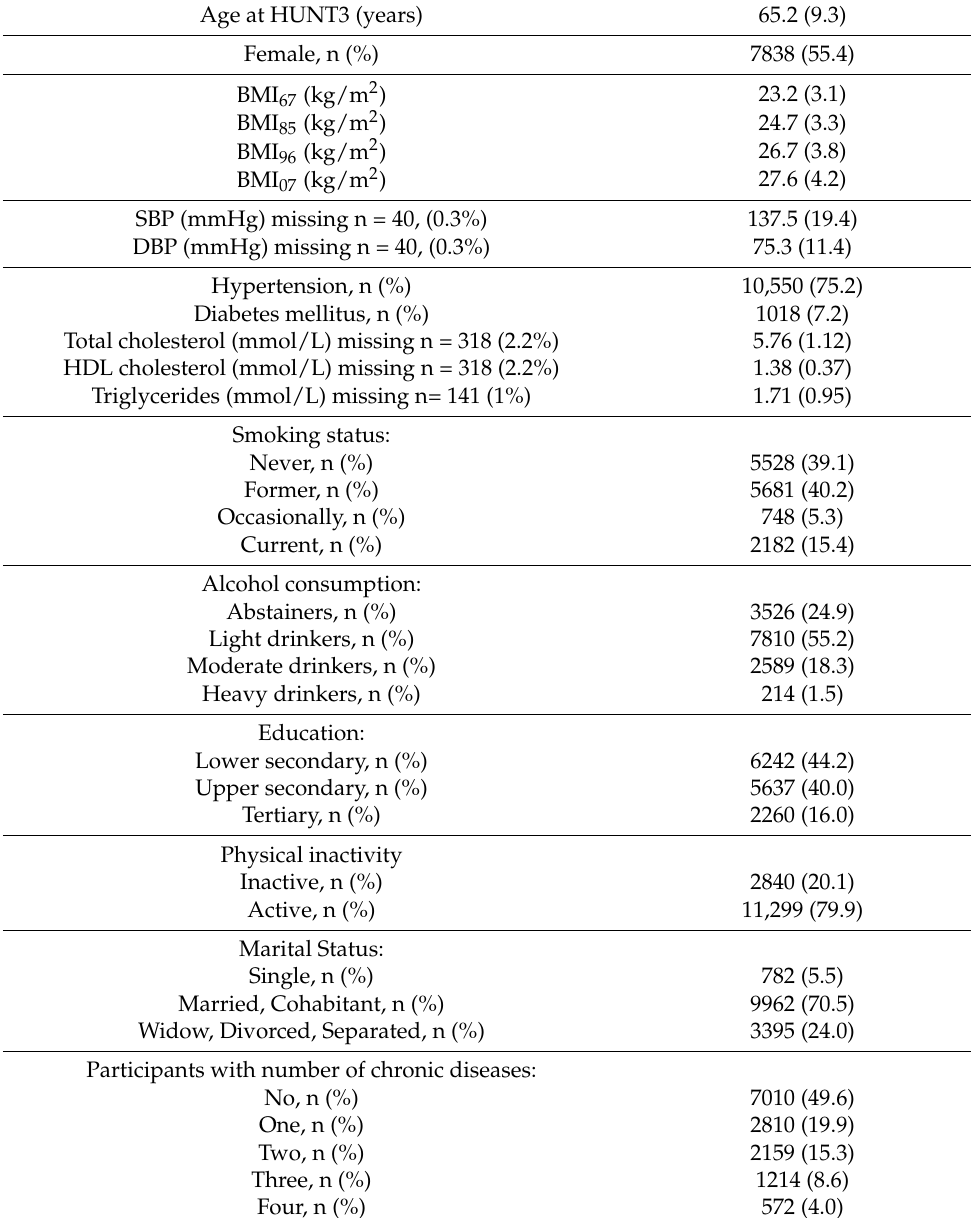
Table 1. Characteristics of the Study Population (n =